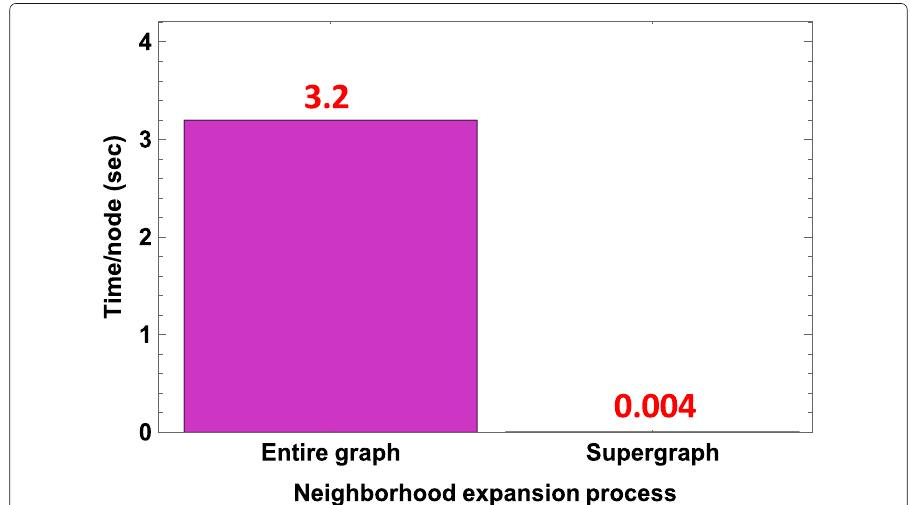
Fig. 10 Runtime analysis of neighborhood expansion process. SURREAL default settings are used: ( u ) | = 1,200, | N ( u ) | = 800, and d = | N E R